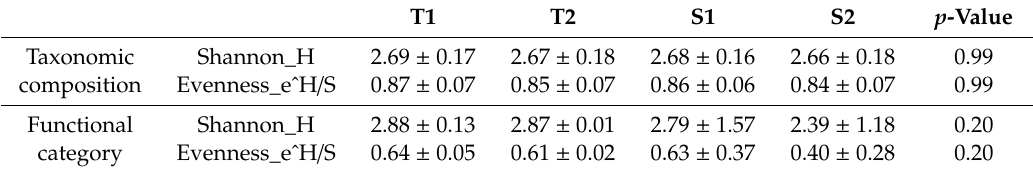
Table 2. Diversity indices for archaeal communities from termite mounds and surrounding soils.